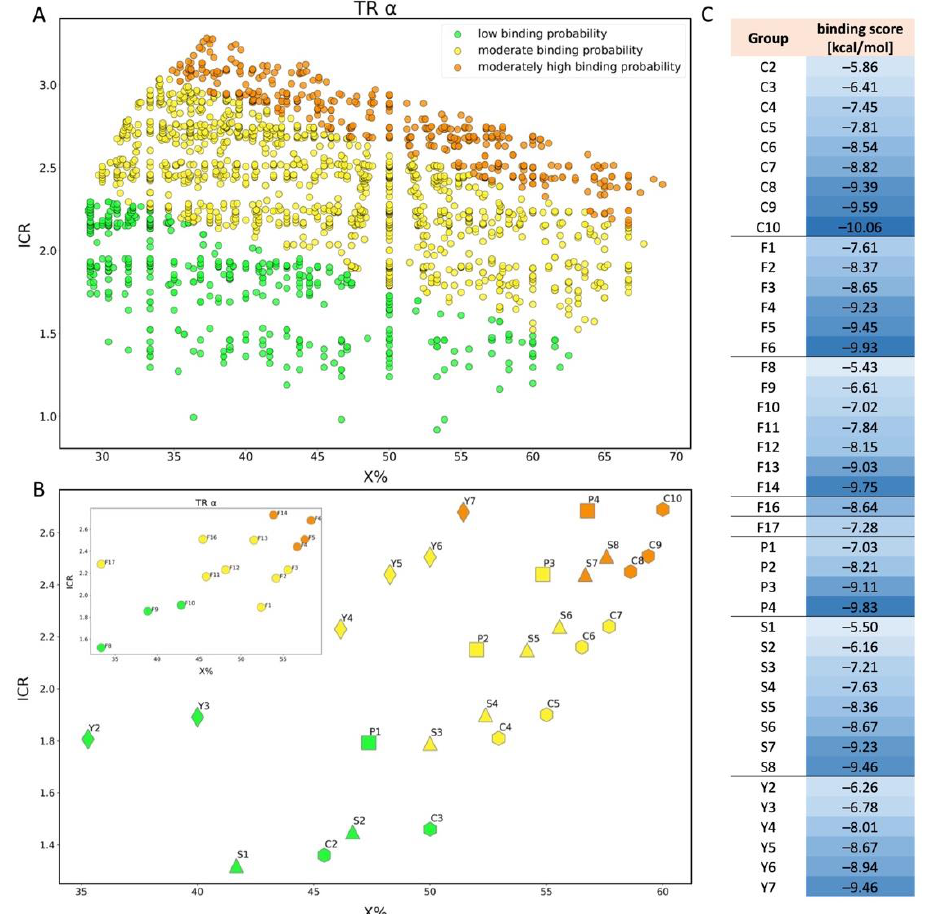
Figure 8. Scatter plot of binding scores obtained for TR α in X% and ICR space ( A ); scatter plot for TR α showing the division of PFAS into 5 different structural groups in space of ICR and X%. C - carboxylic acids (COOH-(CF2)n-CF3), S-sulfonic acids (SO3H-(CF2)n-CF3), P-phosphonic acids (PO3H2-(CF2)n-CF3, F-Fluorotelomer alcohol (F1-F7(OH-(CH2)-(CF2)n-CF3), F8-F14 (OH-(CH2)2-(CF2)n-CF3), F16 (OH-(CH2)3-(CF2)n-CF3), F17 (OH-(CH2)4-(CF2)n-CF3)), Y-dicarboxylic acids (COOH-(CF2)n-COOH). Colors: green-low binding probability, yellow-moderate binding probability, orange-moderately high binding probability ( B ); table showing binding score values for each compound shown in chart B ( C ).